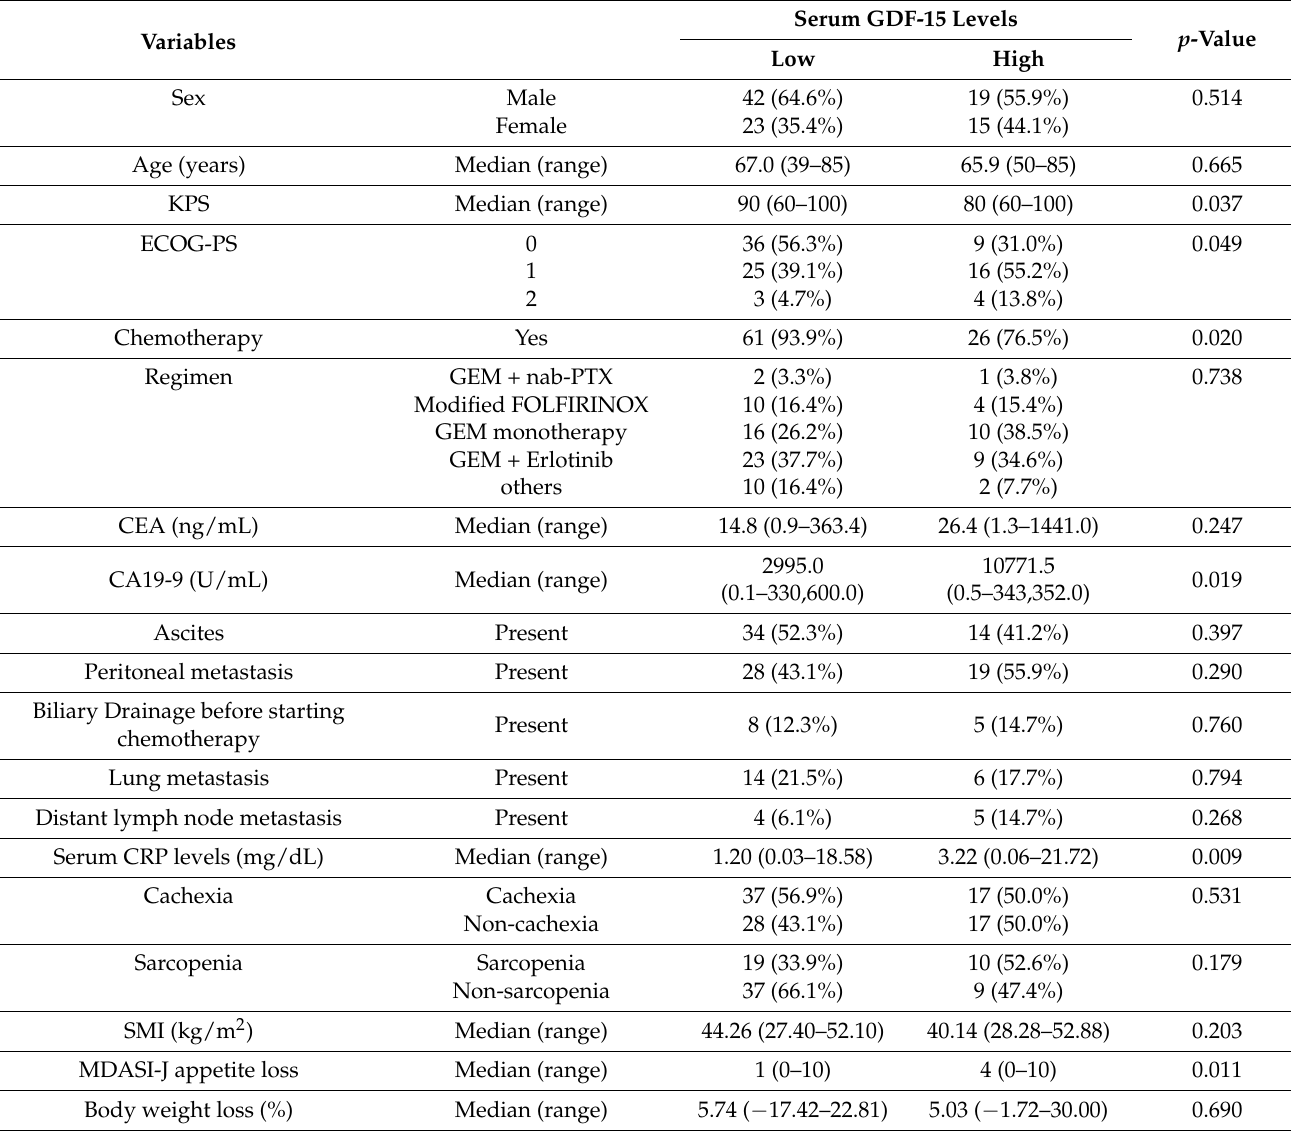
Table 1. Univariate analysis of baseline clinical characteristics to identify factors related to serum GDF-15 levels in patients with metastatic